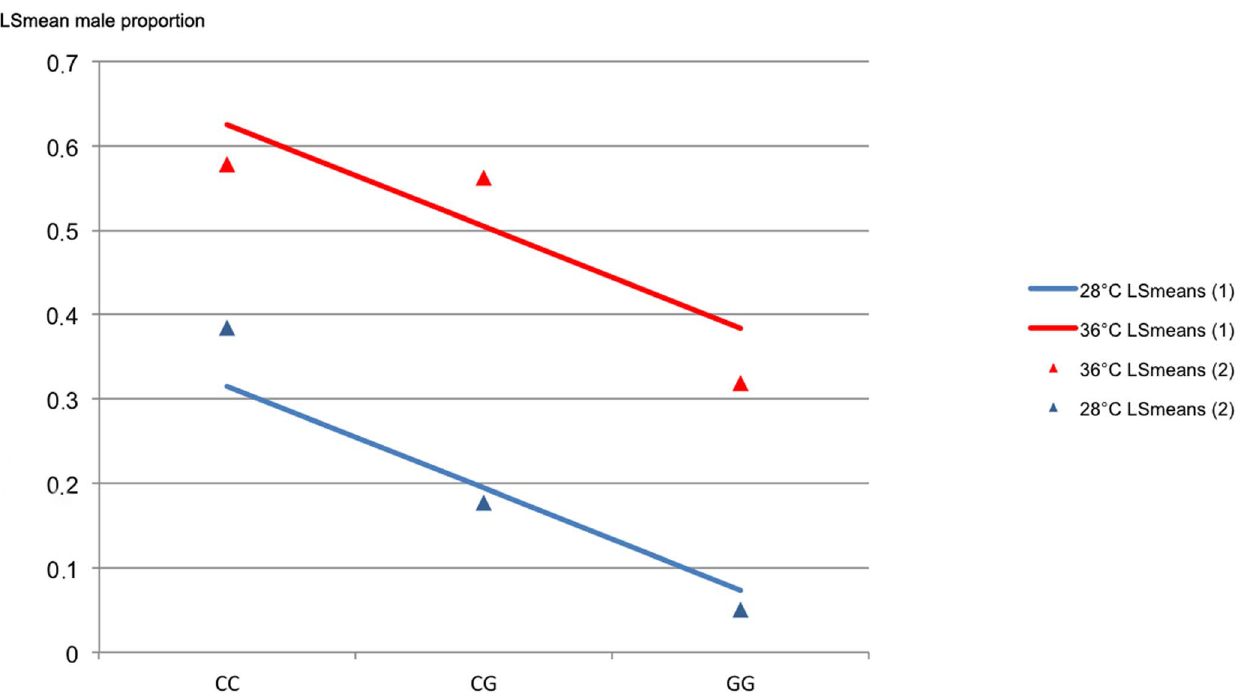
Figure 3. Relationship between male proportion and genotype at amh variant ss831884014 in Nile tilapia, reared at 28 6 C or 36 6 C from 10 to 20 days post fertilisation. Linear least-square regression of the genotypic values (LSmean male proportion) for genotypes C/C, G/C, and G/G at locus ss831884014 of the amh gene (Scaffold GL831234.1 ). The genotypic values were derived from the regression models by either excluding the interaction between SNP and treatment (LSmeans 1: red and blue line) or by including the interaction between SNP and treatment (LSmeans 2: red and blue triangles) as effect class. Numbers of individuals per genotype were 26/79/20 and 114/144/47 for genotypes C/C, G/C, and G/G, for the control group (28 u C) and the group reared at high temperature (36 u C), respectively.